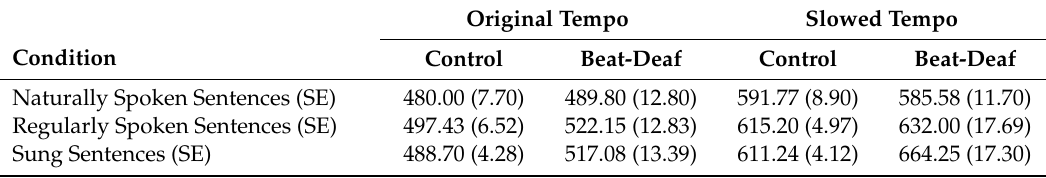
Table 3. Mean inter-tap interval (ITI) in ms for each group according to material type and tempo.